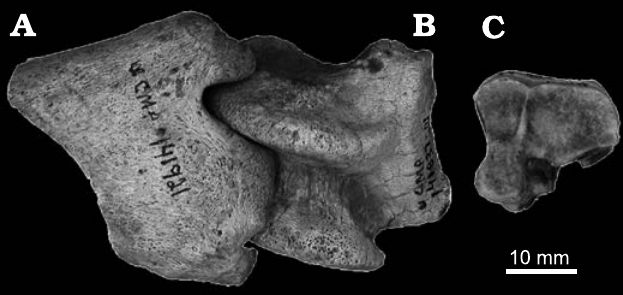
Fig. 7. Articulating distal tibia and astragalus and isolated magnum ele- ments of Equinae gen. et sp. indet. from localities UCMP V70145 (A, B) and UCMP V70142 (C), Eastgate Churchill County, Nevada, USA; early Barstovian, middle Miocene. A . UCMP 141921, distal tibia in anterior view. B . UCMP 141837-01, astragalus in anterior view. C . UCMP 141899-02, magnum in dorsal